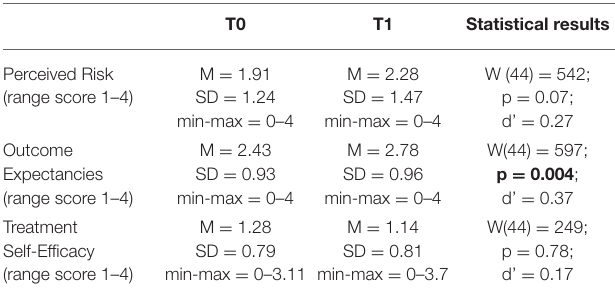
TABLE 1 | Mean, SD, and minimum (min) and maximum (max) for each scale relative to the Self-Efficacy Measure for Sleep Apnea (SEMSA) questionnaire registered at T0 (i.e., before the treatment) and T1 (i.e., after the four-week rehabilitation